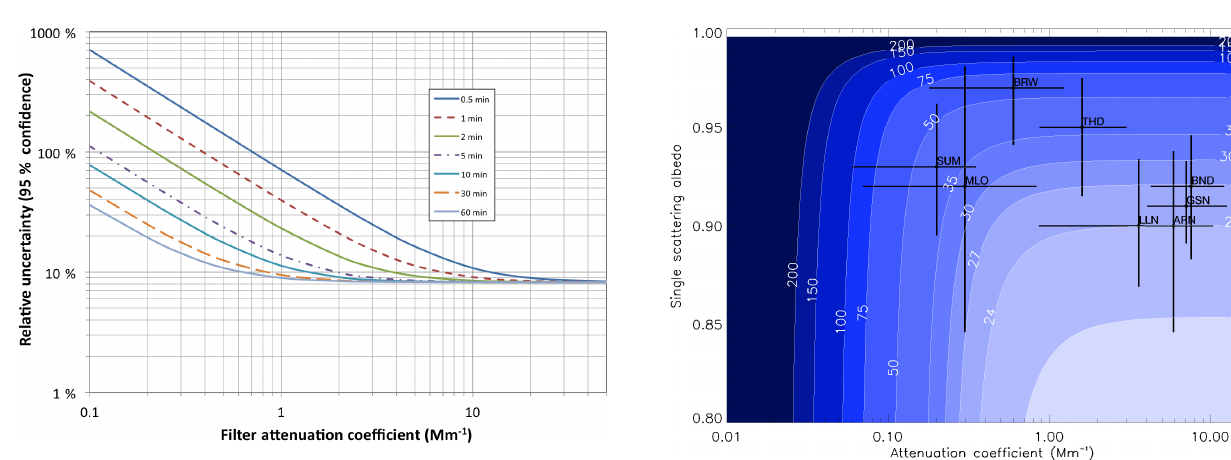
Figure 9. Percent uncertainty of the 30min average light absorp- tion coefficient as a function of single-scattering albedo and atten- uation coefficient. The median uncertainty and interquartile range are shown for values measured for 2013–2016 at eight sites (ARN, El Arenosillo, Spain; BND, Bondville, USA; BRW, Barrow, USA; GSN, Gosan, South Korea; LLN, Mt. Lulin, Taiwan; MLO, Mauna Loa, Hawaii; SUM, Summit, Greenland; THD, Trinidad Head, USA). Uncertainties are given at the 95% confidence